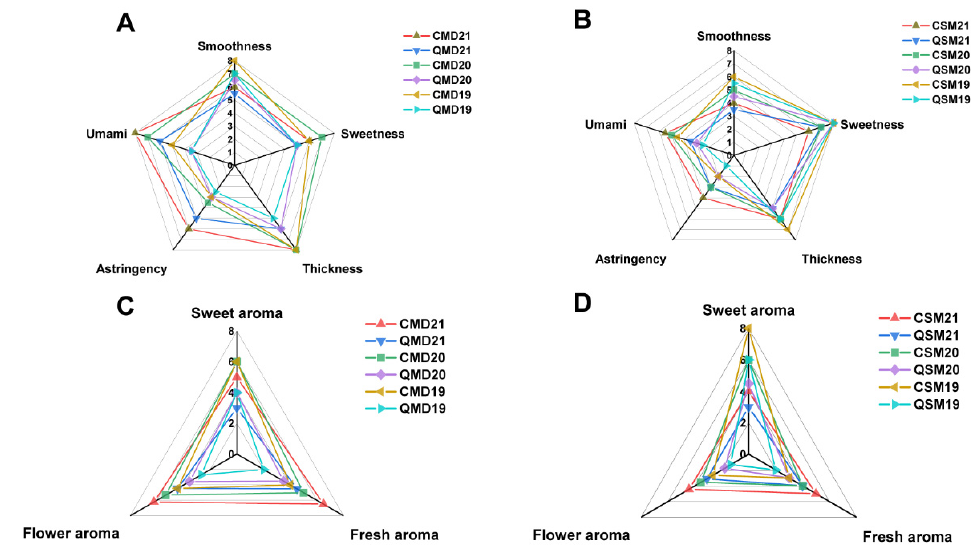
Figure 2. Radar map of the taste and aroma of SP and AP white peony ( A , C ) and Shou Mei ( B , D ) teas. White teas picked in spring were called SPWTs and those picked in autumn were called APWTs. White peony teas and Shou Mei picked in spring were termed CMD19-21 and CSM19-21, respectively, while those picked in autumn were correspondingly named QMD19-21 and QSM19-21. The number following CMD, QMD, CSM, and QSM represented the production years, corresponding to 2019, 2020, and 2021, respectively (Table